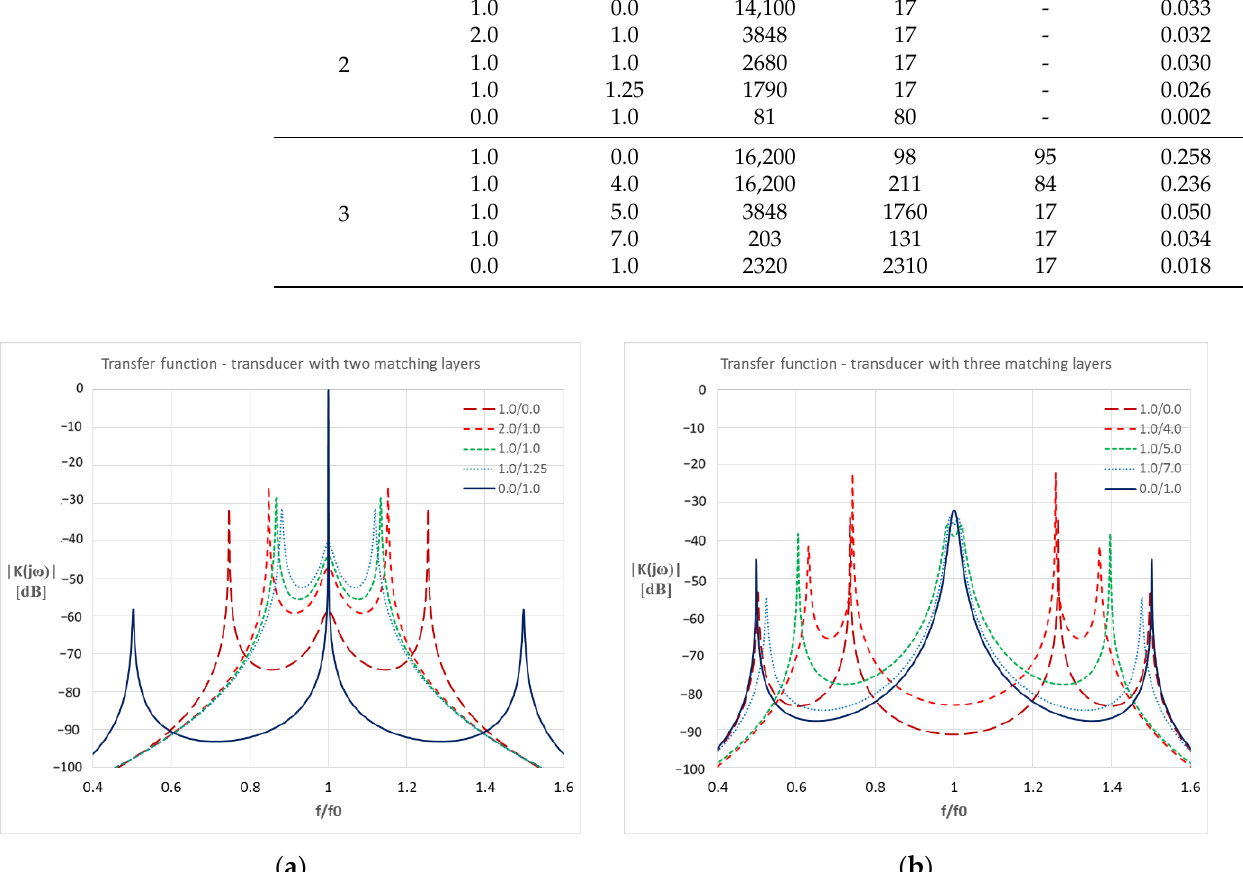
Figure 4. Analysis of the transfer function for the transducer operated in air: ( a ) with 2 matching layers, ( b ) with 3 matching layers.